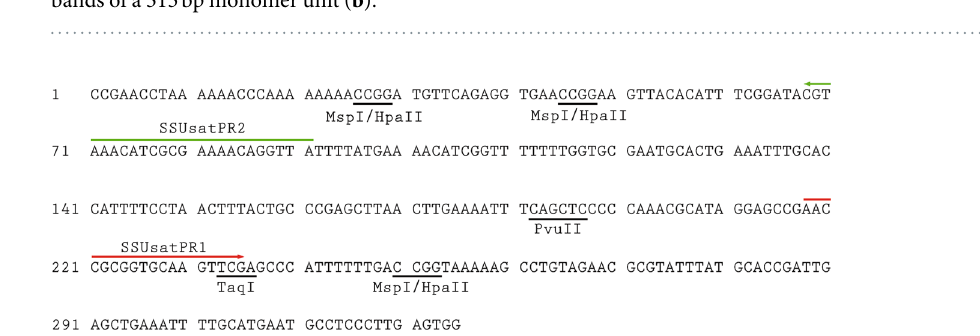
Figure 1. Southern blot hybridisation analysis of SSUsat repeats in Spisula subtruncata . Agarose gel electrophoresis of Pvu II and Hae III digested genomic DNA of Spisula subtruncata showing ladder-like multimer bands of a 315 bp monomer unit ( a ). After being Southern blotted on a nitrocellulose membrane, the electrophoresed DNA was hybridised with an SSUsat monomer probe yielding identical ladder-like multimer bands of a 315 bp monomer unit ( b ).